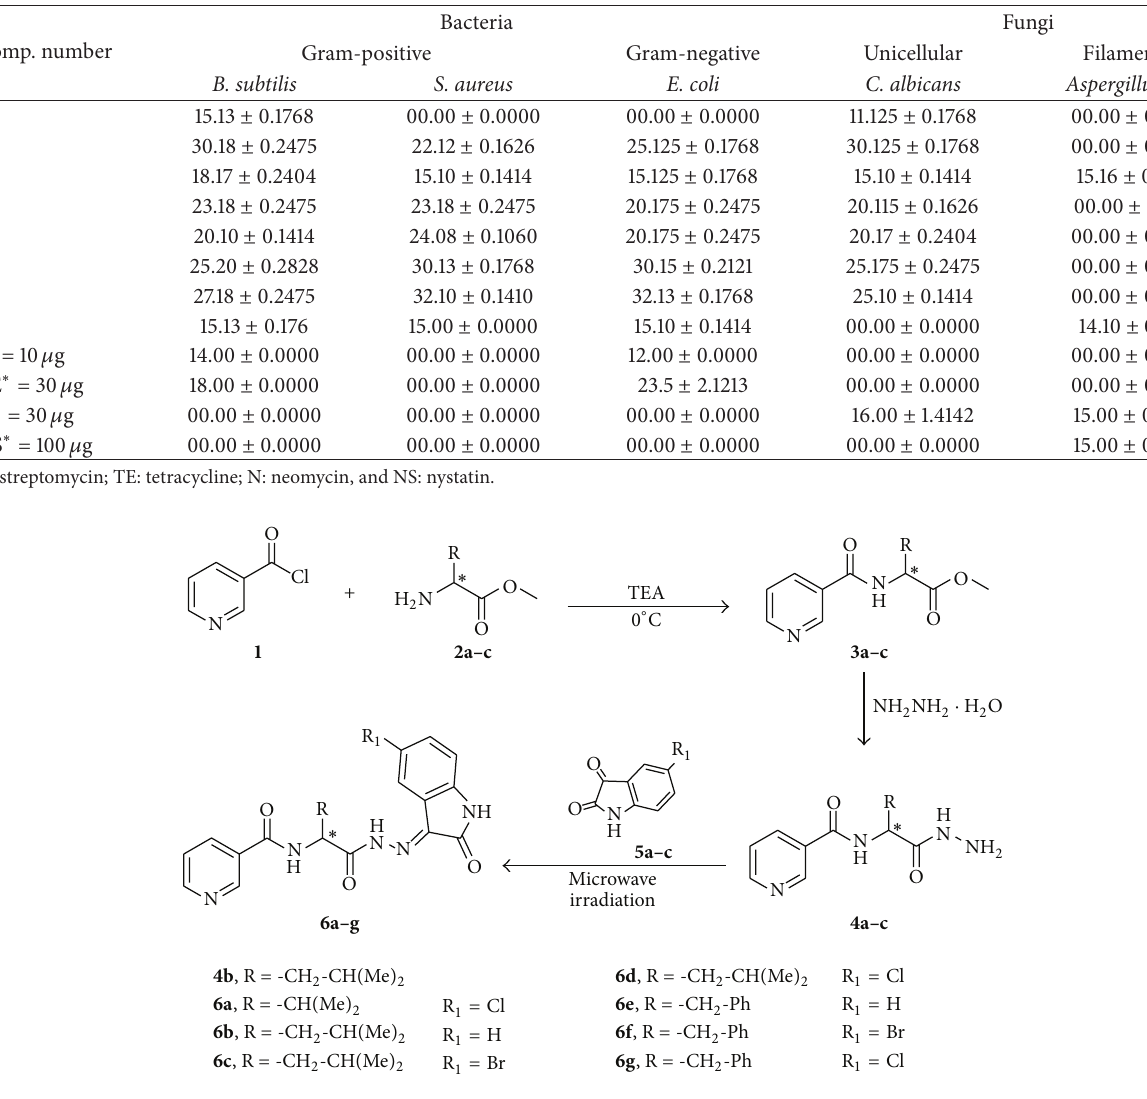
Scheme 1: Synthetic routes for compounds 4b and 6a–g